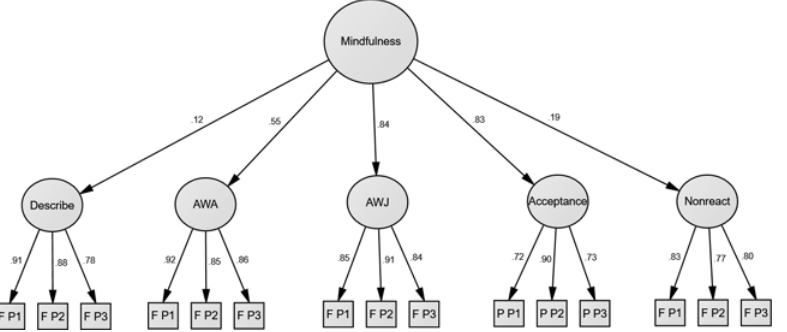
Fig 3. Results for Joint Confirmatory Factor Analysis of the Five Facet Mindfulness Questionnaire (minus the Observe facet) [18], Philadelphia Mindfulness Scale [40], and Toronto Mindfulness Scale [39] in Sample 1 ( N = 395). First-order latent variables derive from item parcels (three per facet). Error terms are omitted for visual clarity. AWA = Act with Awareness; AWJ = Accept w/o Judgment; F = Five Facet Mindfulness Questionnaire; P = Philadelphia Mindfulness Scale; P1 to P3 = Parcels 1 to 3. All standardised coefficients are significant at the .05